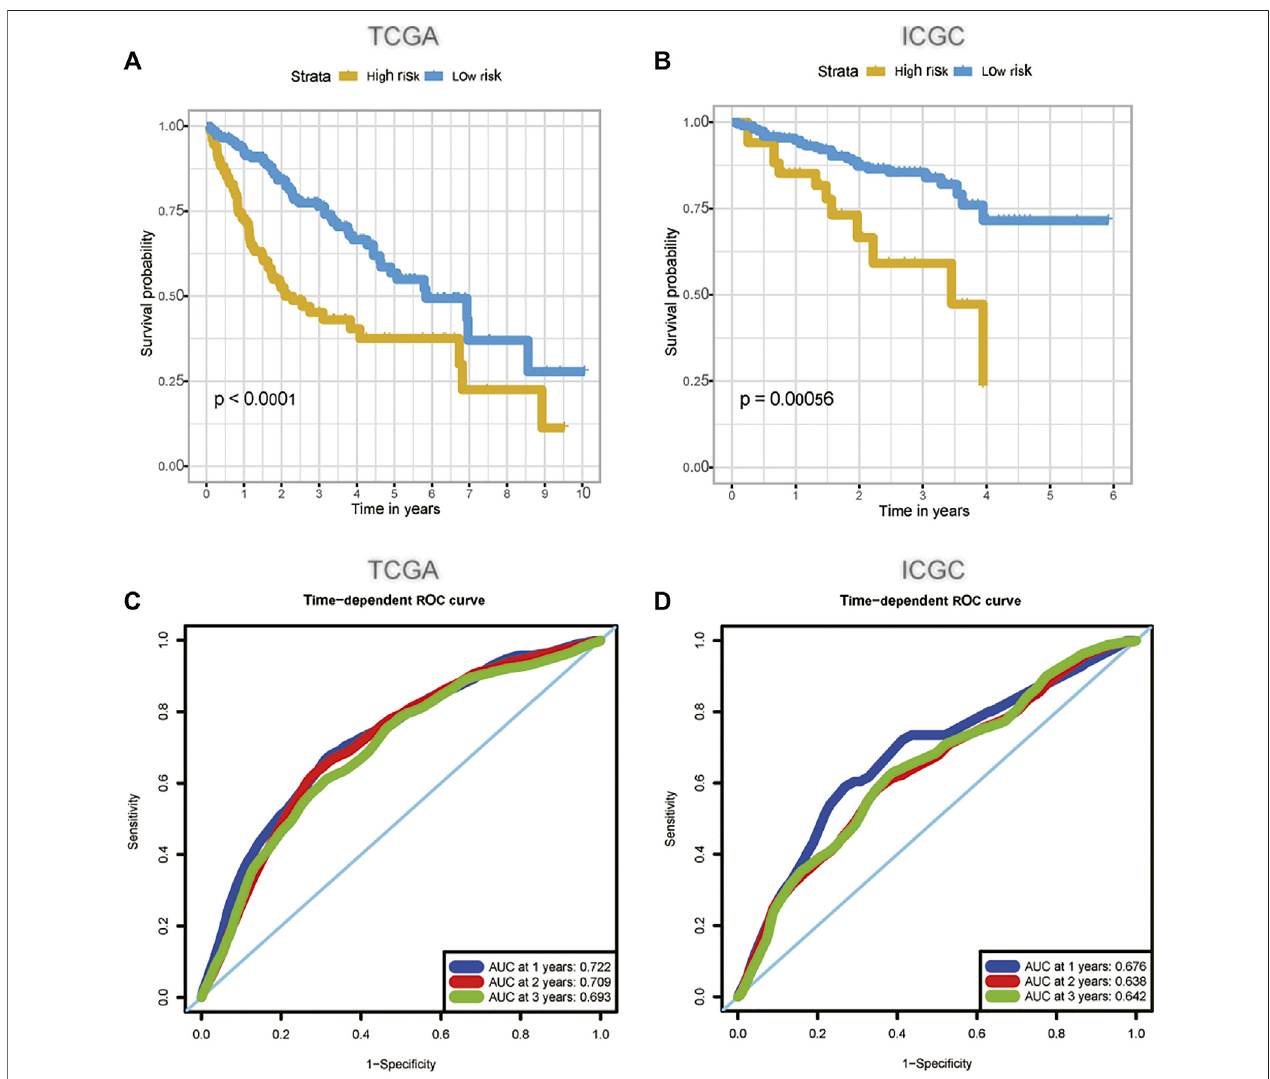
FIGURE5| Thepredictivevalueofm6A-relatedlncRNAsignatureintheTCGA (A,C) andtheICGC (B,D) dataset. (A) ThesurvivalcurveofHCCpatientsinthehigh and low-risk groups in the TCGA dataset; (B) The survival curve of HCC patients in the high and low-risk groups in the ICGC dataset; (C) The ability of m6A-related lncRNAsignaturetopredicttheoverallsurvivalofHCCpatientsintheTCGAdataset; (D) Theabilityofm6A-relatedlncRNAsignaturetopredicttheoverallsurvivalofHCC patients in the ICGC dataset. HCC, hepatocellular carcinoma; TCGA, The Cancer Genome Atlas; ICGC, International Cancer Genome Consortium.